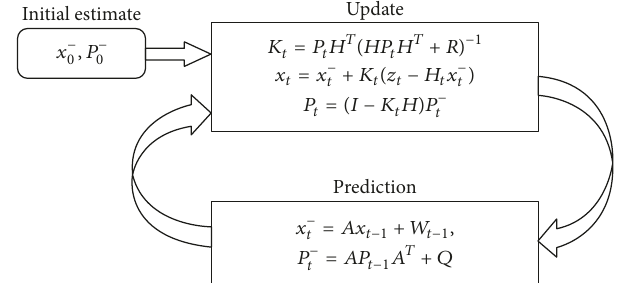
Figure 7: The iteration iterative cycle of